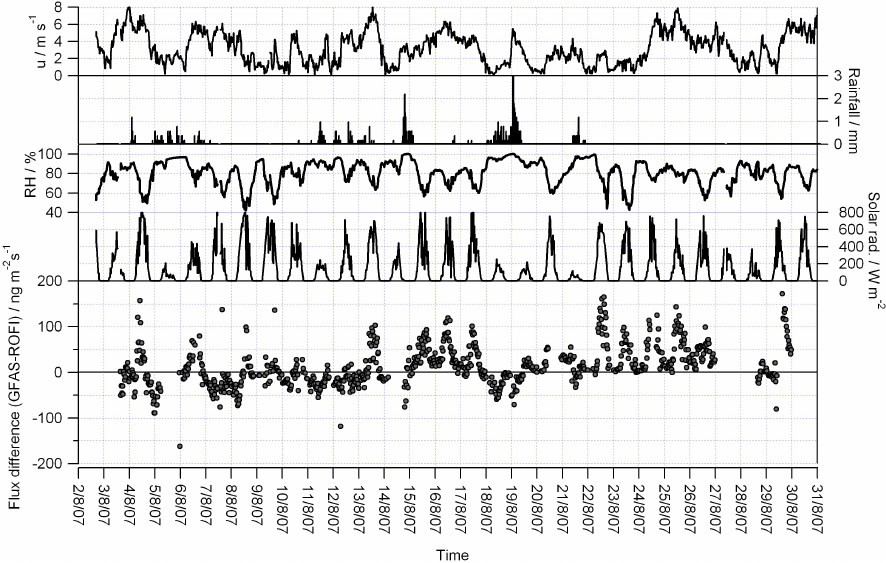
Fig. 6. Time series of wind speed, rainfall, relative humidity, solar radiation and difference of mean GFAS and ROFI fluxes by DCM.